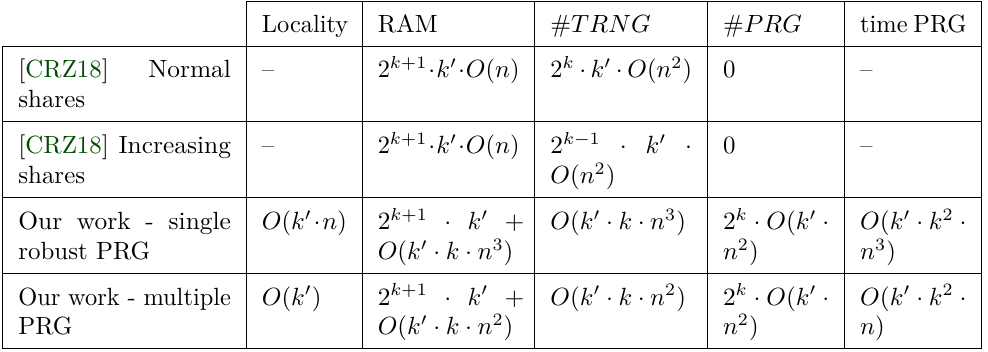
Table 1: Comparison of asymptotic complexities of our work vs. [CRZ18] to implement a ( k, k 0 ) S-box using higher-order masked lookup table scheme. The schemes are compared in terms of locality, RAM memory in bits, number of TRNG and PRG calls, and time to generate a pseudorandom